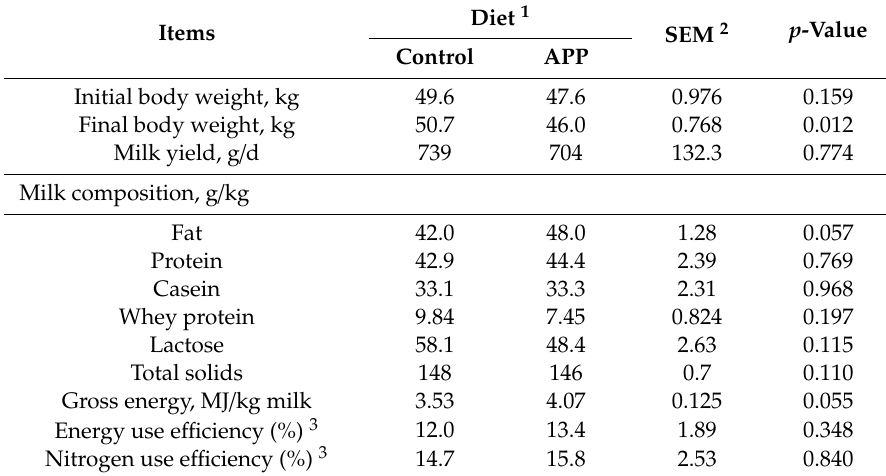
Table 4. Average values of body weight and milk yield and composition in dairy goats fed the experimental